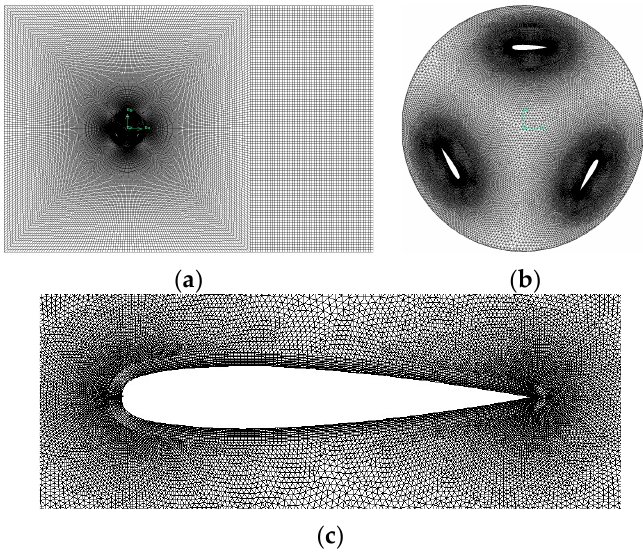
Figure 5. Detailed grids of the LE-5% c model ( a ) entire grids of computational region; ( b ) grids of rotating region; ( c ) grids around airfoil.